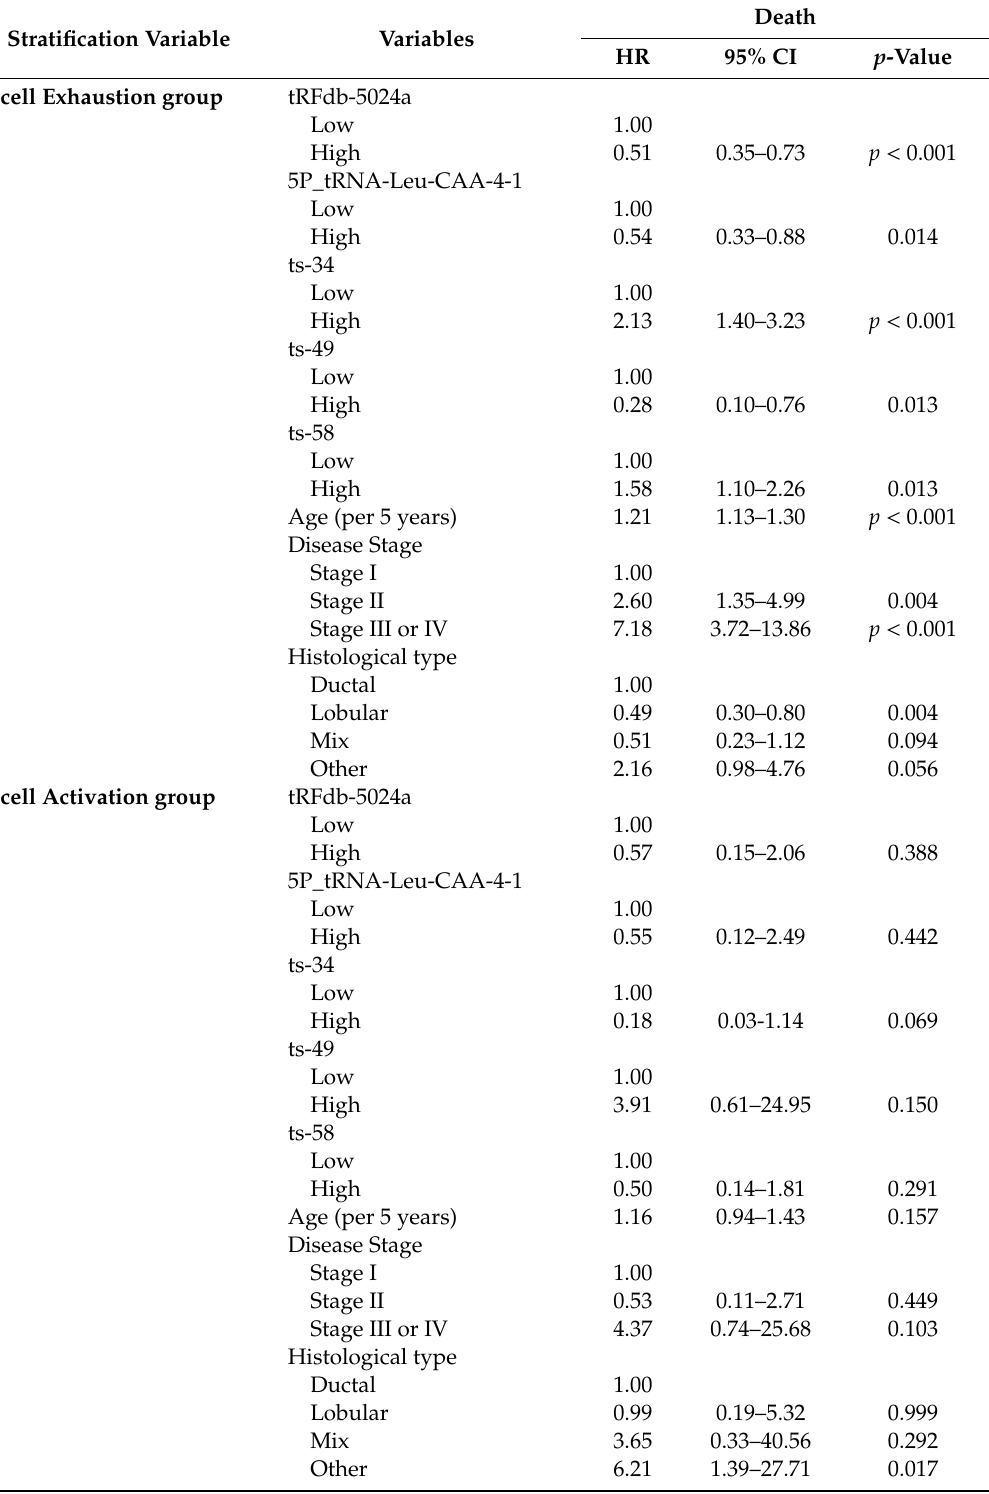
Table 3. Relationships between overall survival and tRFs stratified by T cell activation status. Stratification